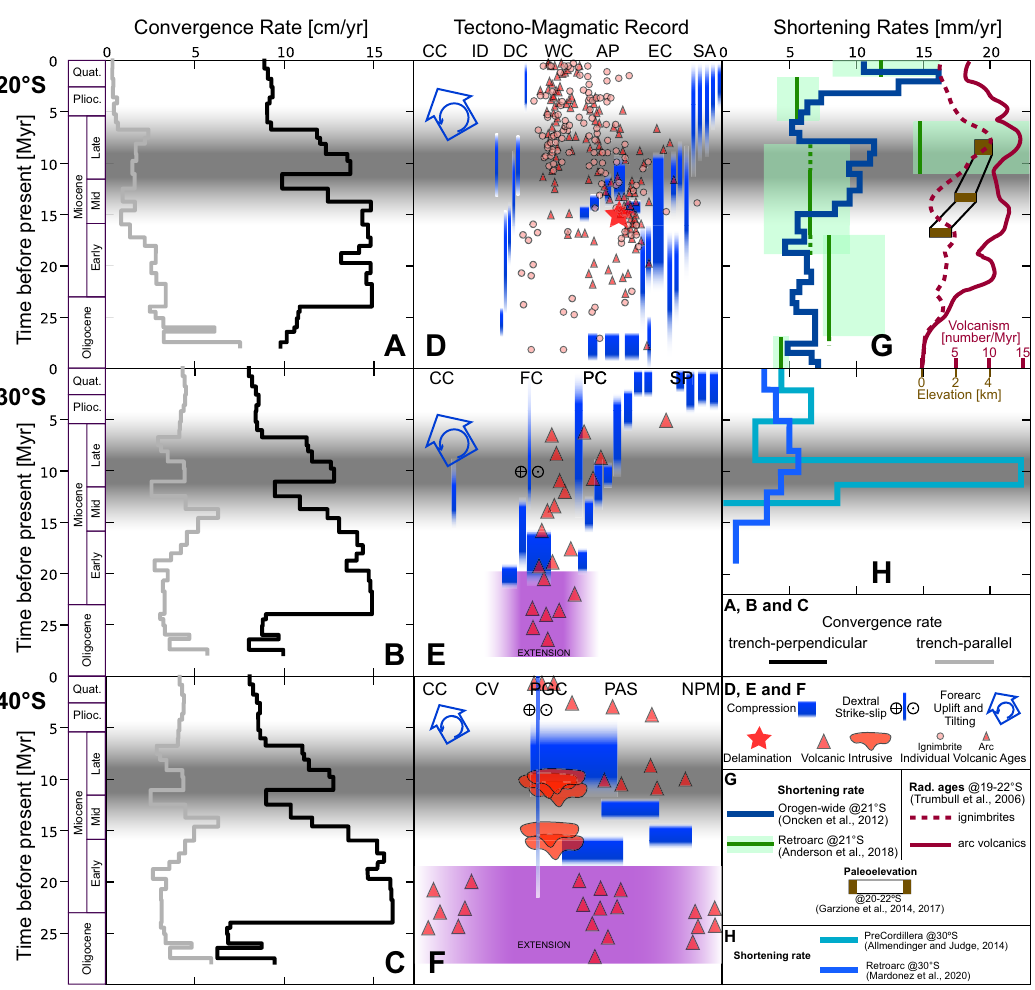
Fig. 3 Trench-parallel and trench-perpendicular components of convergence velocity compared to the tectono-magmatic evolution of the Andean margin. A – C shows the temporal evolution of convergence velocity at 20°, 30°, and 40°S (respectively) decomposed on its trench-perpendicular (black line) and trench-parallel (grey line) components (alternatives with time-changing trench axis are available as Figs. S2A – C of Supplementary Information). D – F displays a compilation of main tectonic and magmatic events that occurred across the continental margin at 20°, 30°, and 40°S (respectively). Note as a reference the approximate west (left) to east (right) location of morpho-structural units at the top of each panel (labels are de fi ned in Fig. 1). The thickness of blue bars indicates the approximate EW extend of compressive deformation events as informed by original authors (see Supplementary Information). G , H show estimates of shortening rates at the scale of the whole orogen and for the retroarc region near 20° and 30°S (respectively). G also includes time-varying estimates of paleoelevation and variations in the productivity of volcanism (expressed by the number of reported geochronological ages for ignimbrites and arc lavas). Sources of published information used to construct D to H are described in the Supplementary Information. Horizontal grey bands mark the time interval between 15 and 5 Ma, with emphasis between 11 and 9 Ma, which is the time when our model shows the most important differences with respect to